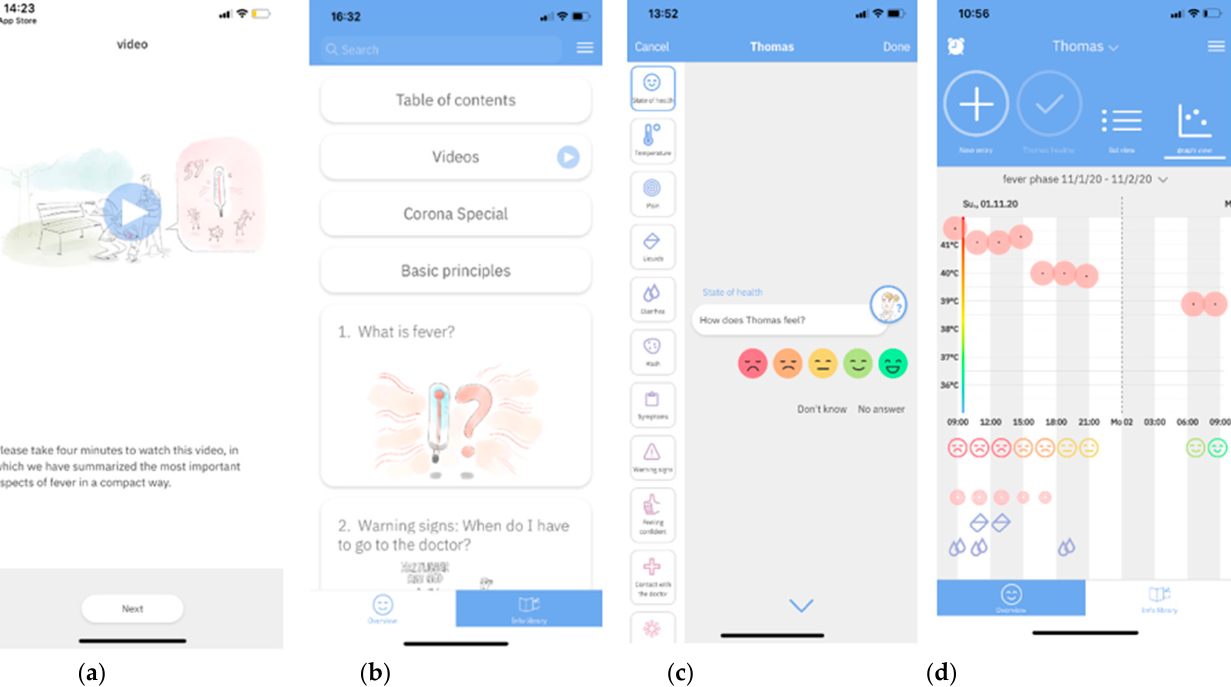
Figure 1. ( a ) Educational video; ( b ) Info Library-Menu; ( c ) Entry start; and ( d ) Graph